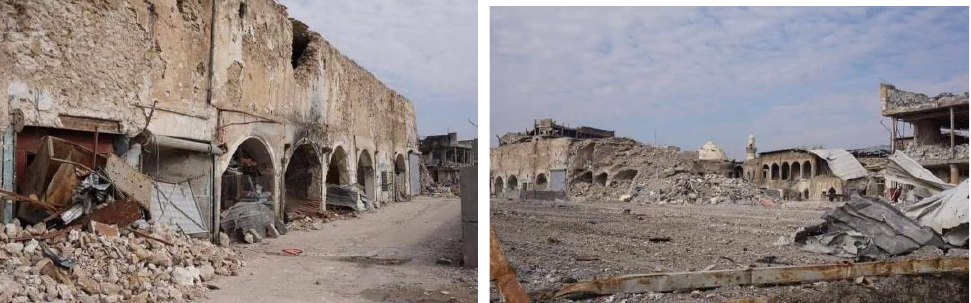
Figure 9. The extent of the destruction and damage in Khan Hamo Qaddo after the military opera- tions in 2017. (Photo credit: Nineveh Governorate and the Municipality of Mosul, Department of Media) [28].